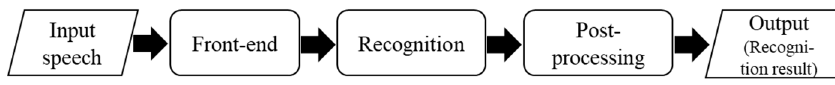
Figure 1. Procedure of standard speech recognition systems.